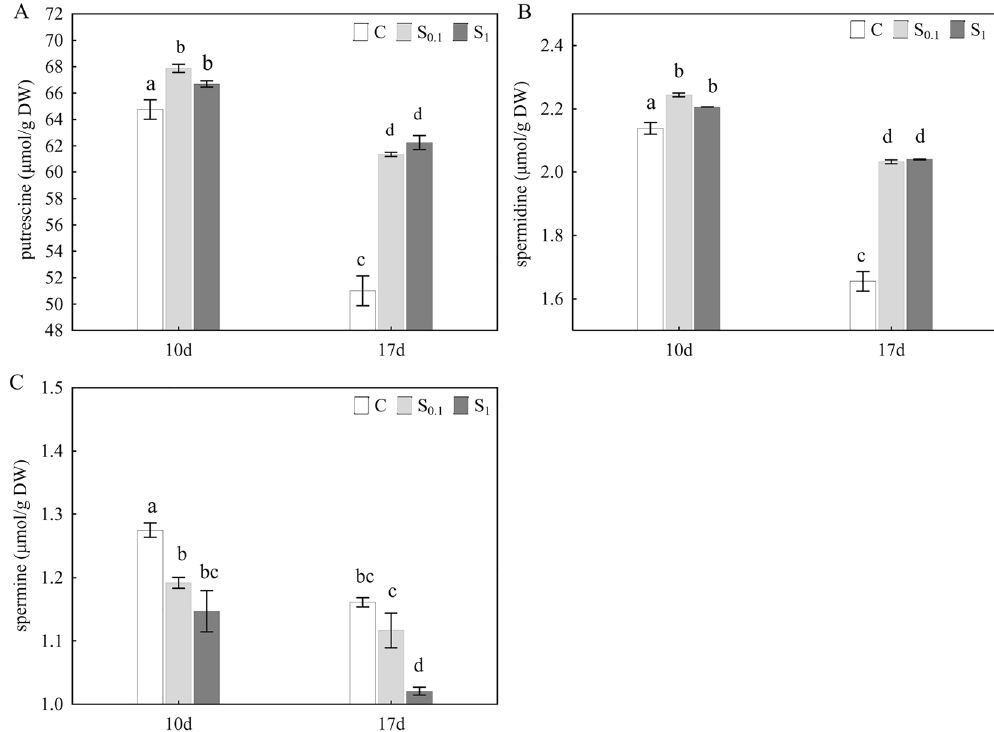
Figure 4. Putrescine ( A ), spermidine ( B ) and spermine ( C ) concentration in honey bee body in µmol/g DW (dry weight) after 10 (10d) and 17 days (17d). Control C was fed with 50% sucrose solution, and in groups S 0.1 and S 1 diet was supplemented with 0.1 mM and 1 mM spermidine, respectively. Data is presented as mean ± standard error (SE). Differences between mean values were analyzed with one-way ANOVA and post- hoc Duncan’s test. Different letters indicate differences among all experimental groups shown on the graph for * p < 0.05.